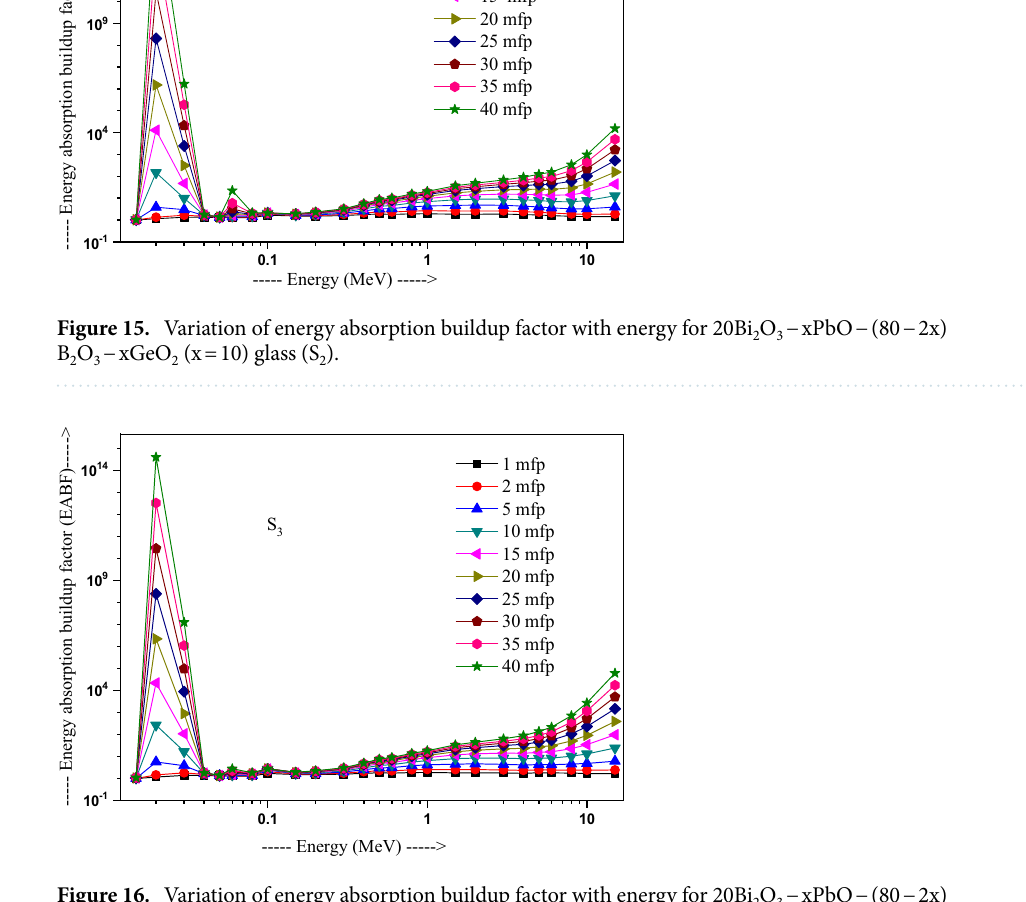
Figure 16. Variation of energy absorption buildup factor with energy for 20Bi 2 O 3 − xPbO − (80 − 2x) B 2 O 3 − xGeO 2 (x = 20) glass (S 3